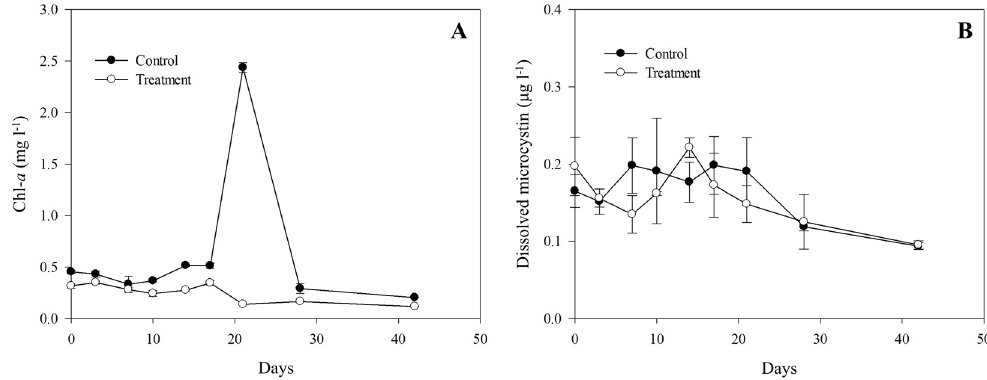
Figure 2. Concentrations of ( A ) Chl- a and ( B ) dissolved microcystin in the surface water of the mesocosms. Error bars represent standard deviations.